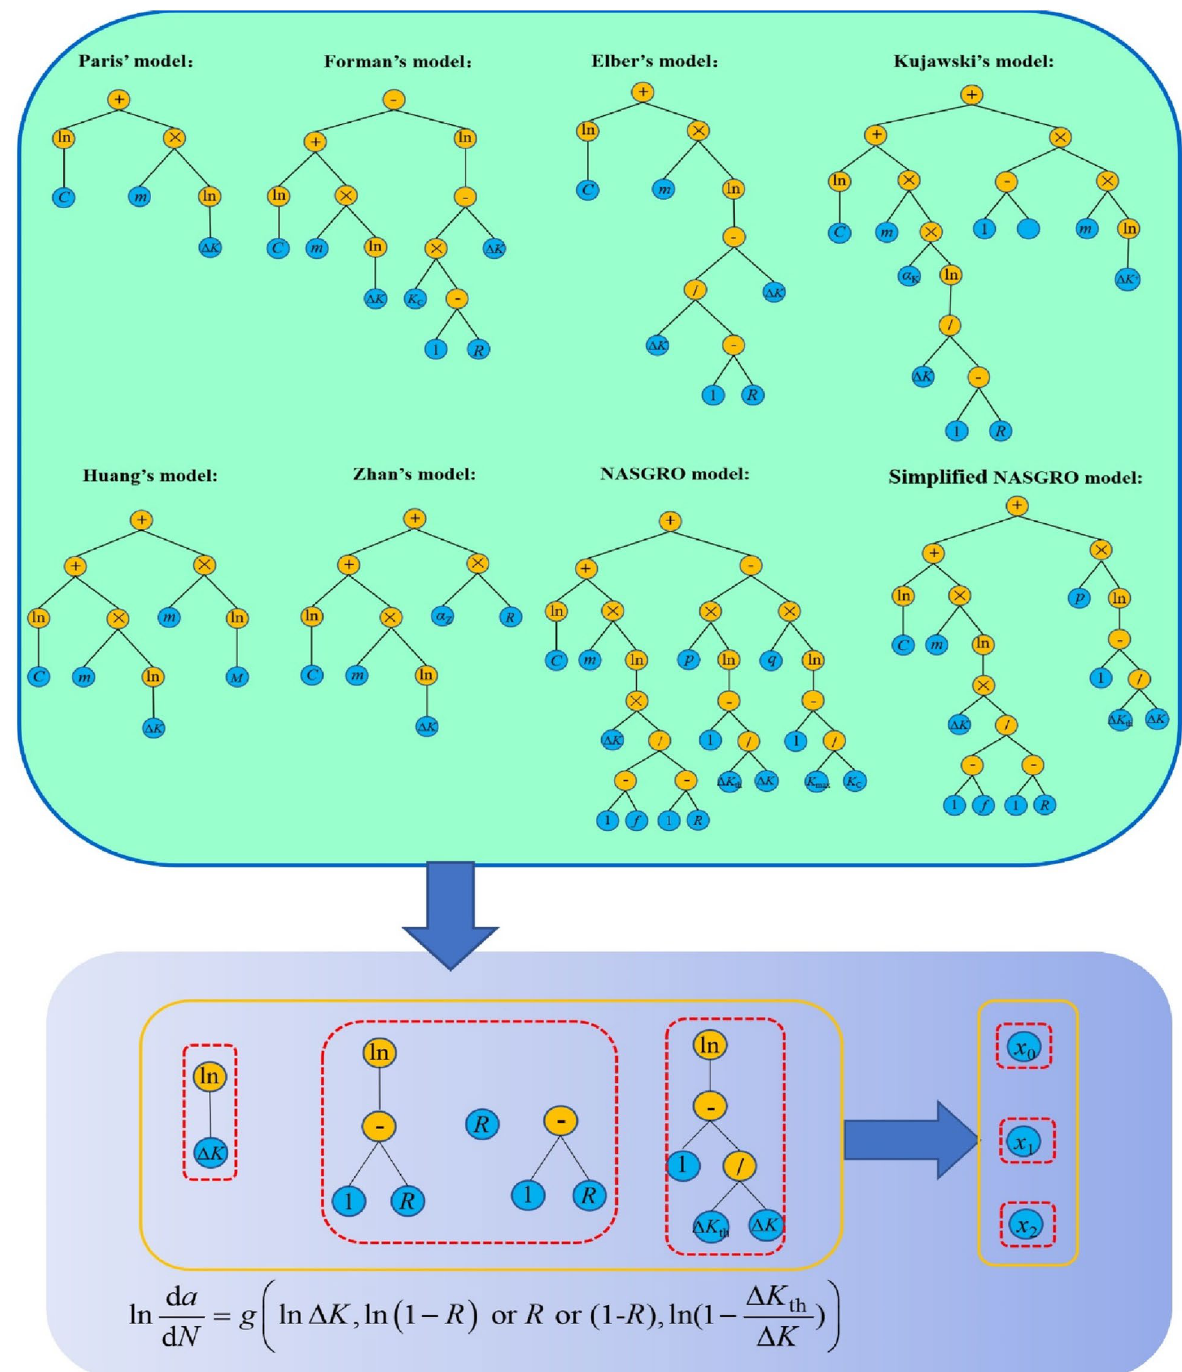
Figure 4 SR trees of eight traditional models equation for FCG rates prediction and formula